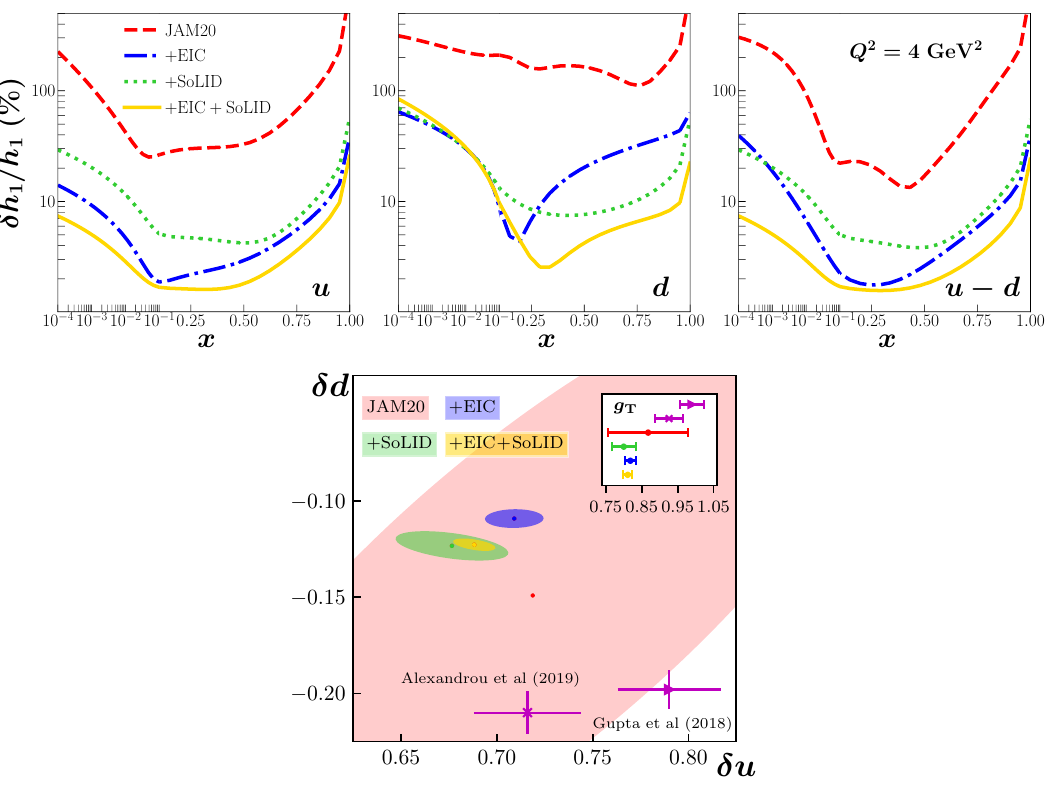
Figure 4: (Top) The ratio of the error of transversity to its central value for u , d , and u − d for JAM20 (red dashed line), JAM20 + EIC pseudo-data (blue dash-dotted line), JAM20 + SoLID pseudo-data (green dotted line), and JAM20 + EIC + SoLID pseudo- data (gold solid line). (Bottom) Individual flavor tensor charges δ u , δ d as well as the isovector charge g for the same T